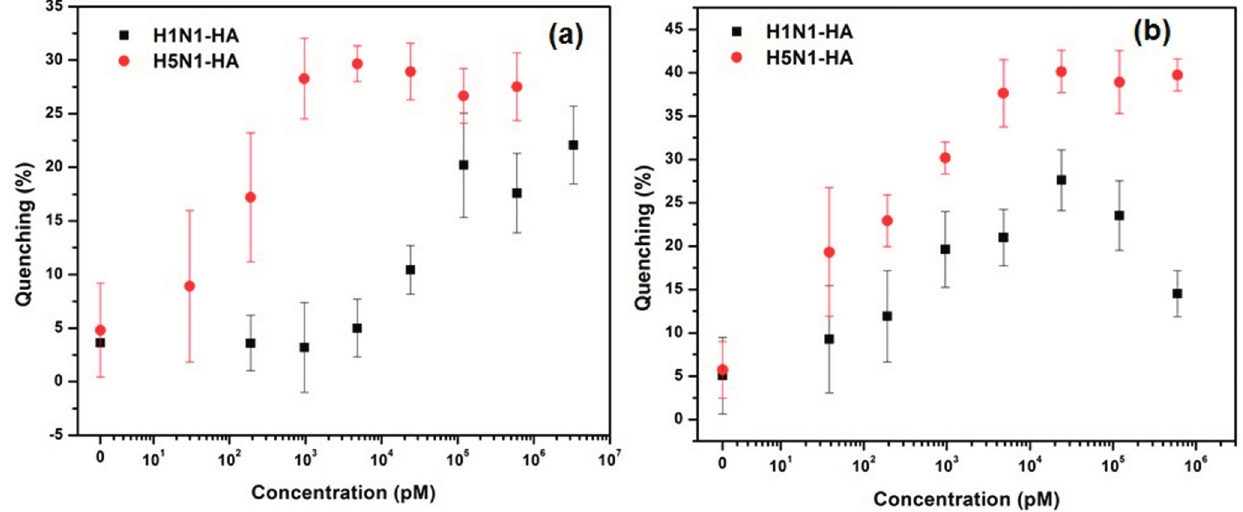
Figure 5. Detection of human influenza virus H1N1-HA and avian H5N1-HA by 6G-QDs/mAb- H1-Au NPs mixture and 3G-QDs/mAb-H5-Au NPs mixture, in PBS ( a ) and in human sera spiked PBS ( b ), respectively. (N =